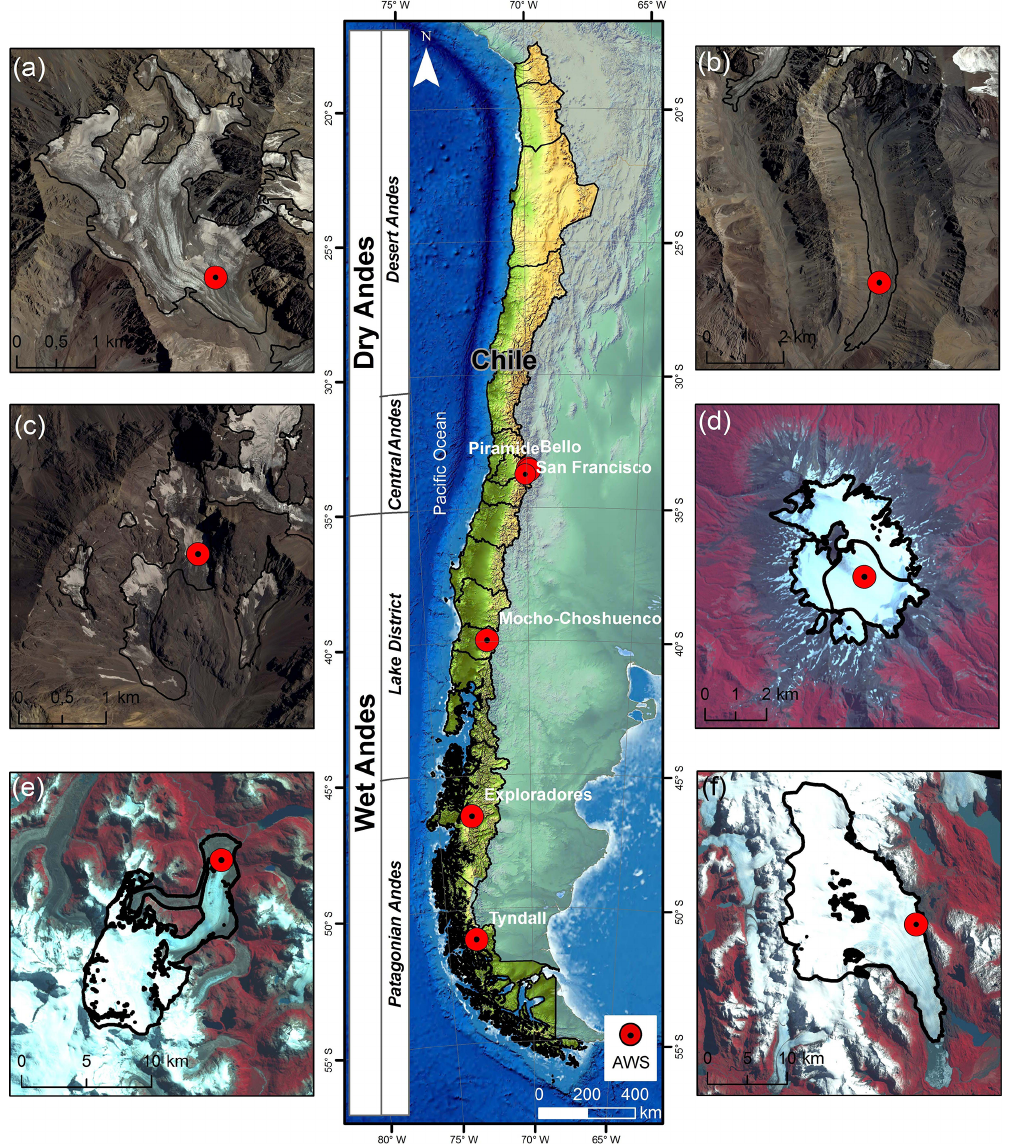
Figure 1. Middle: glaciological zones in Chile according to Lliboutry (1998) and locations of the studied glaciers: (a) Bello Glacier, (b) Pirámide Glacier, (c) San Francisco Glacier, (d) Mocho Glacier, (e) Exploradores Glacier (background: SRTM), (f) Tyndall Glacier. Background images courtesy of DGA and